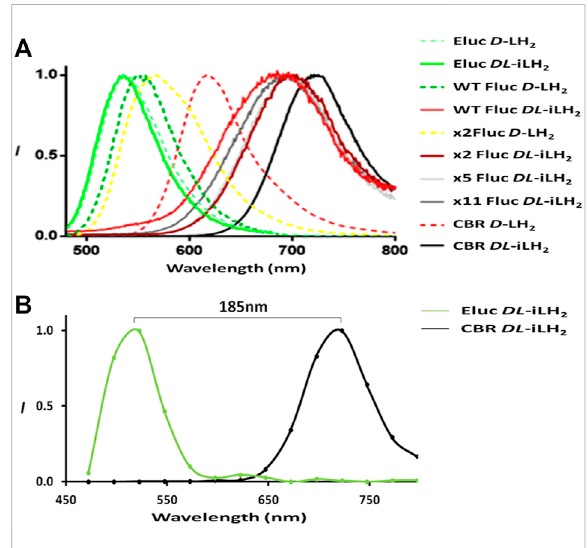
FIGURE 3 Expanded bioluminescencespectralrange with infraluciferin. (A) Bioluminescence spectra of different luciferases with D -LH 2 and DL -iLH 2 : 5 μ M enzymes were assayed with 200 μ M luciferins and 2 mM ATP, and light was captured using the Clariostar instrument. For ease of visualization, x5 and x11 Fluc spectra with D -LH 2 are omitted but are near identical to WT Fluc (Reference, Table 1). (B) Illustration of spectral separation between Eluc